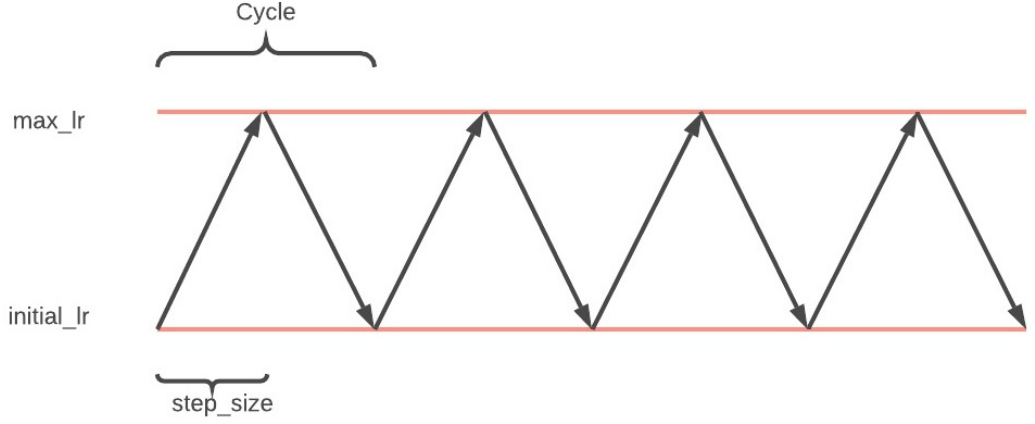
Figure 6. Cyclical learning rate with triangular policy